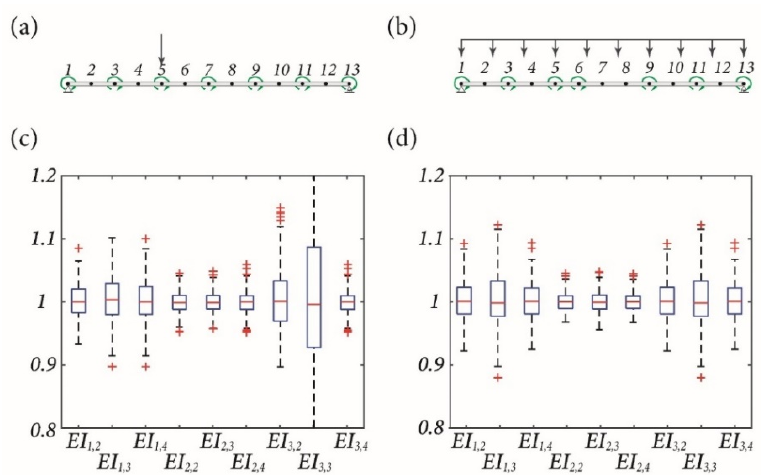
Figure 10. ( a ) Load case 1 (a concentrated load on the one-third point) and the measurement location; ( b ) load case 2 (a uniform load over the span) and the measurement location; ( c ) boxplots of the estimations under load case 1; ( d ) boxplots of the estimations using under load case 2 (note: EI i,j means the estimation of EI i using strategy j ).